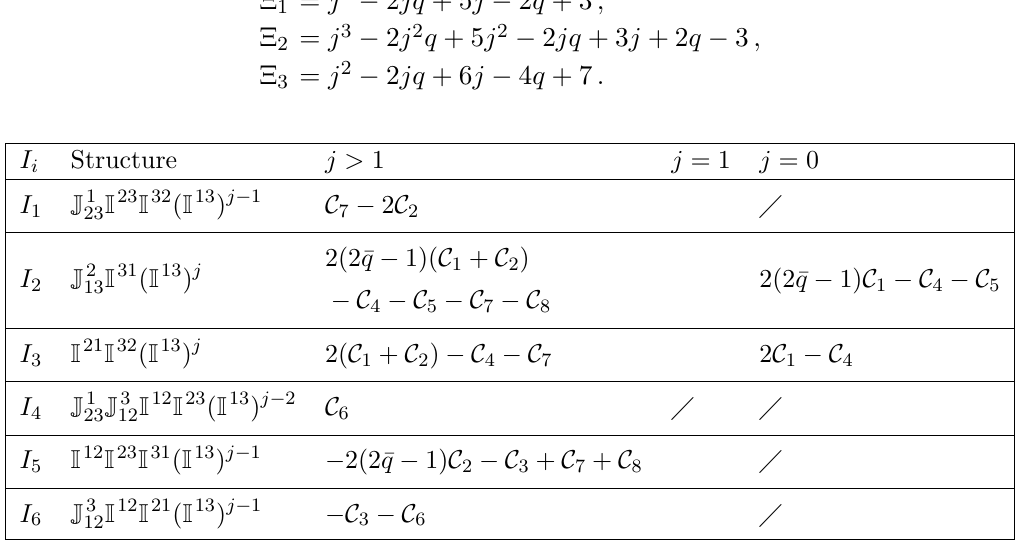
( QO ) J ( QO ) when QO h i = 0. C 6